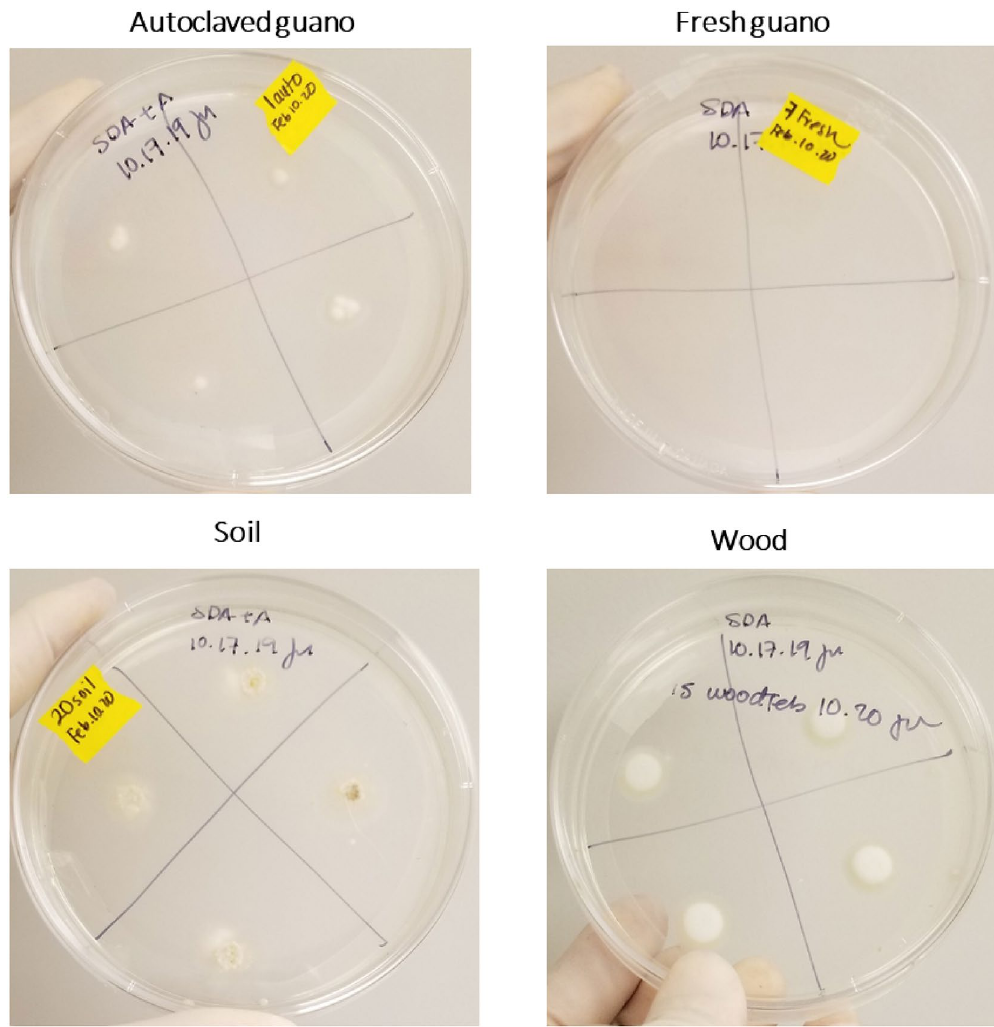
Figure 7. Growth of Pd in SDA plates 14 days after plating 10 μl of harvesting liquid obtained from leftovers of the different substrates